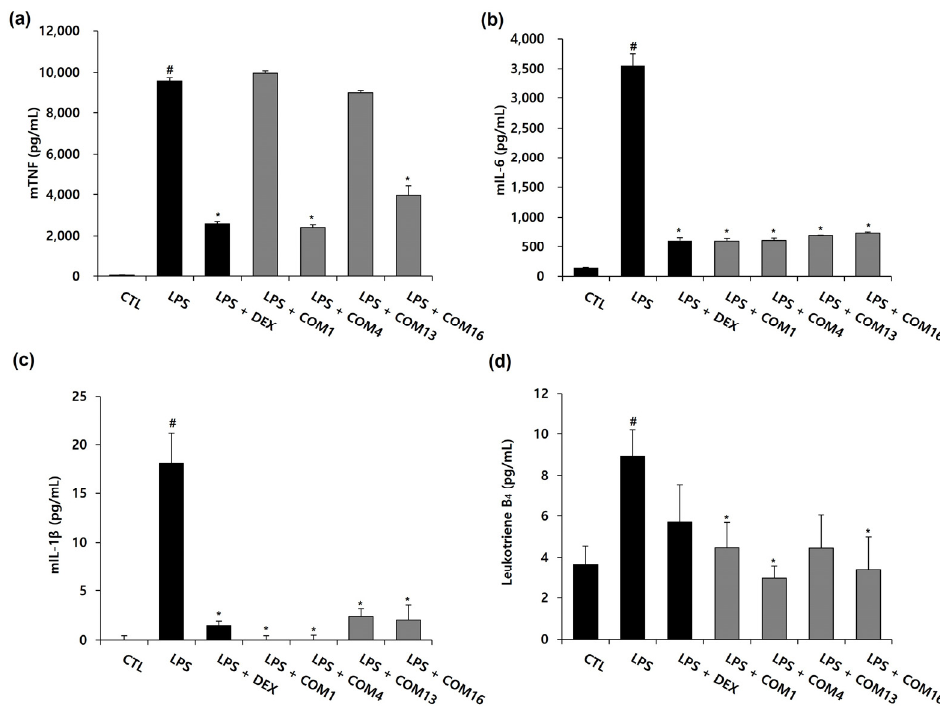
Figure 5. Effects of the drug combinations on the LPS-induced production of inflammatory cytokines in RAW264.7 cells. Murine macrophages were pretreated with 1 mg/mL of the drug combination 1, 4, 13, and 16 (drug combination 1 (COM1), EH: 0.273 g and PR: 0.263 g; drug combination 4